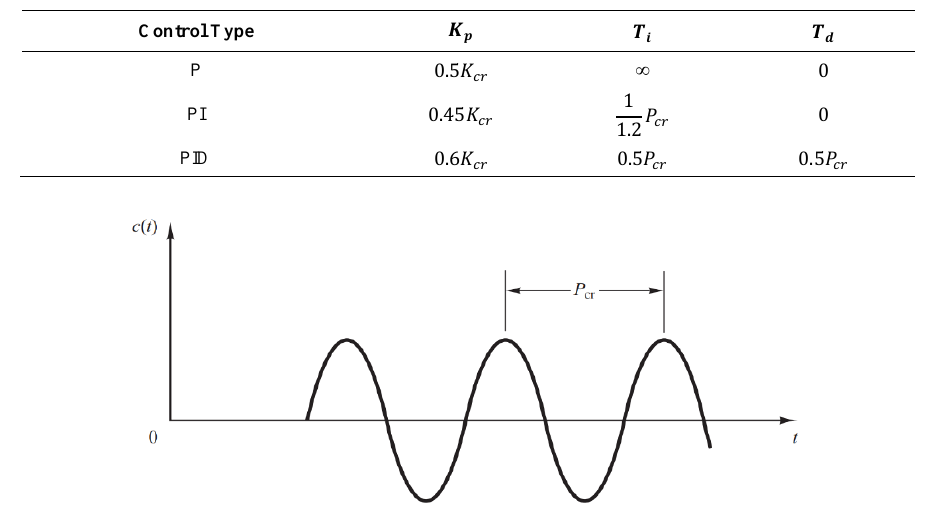
Table 1. PID formulation based on the second method of Zigler-Nichols